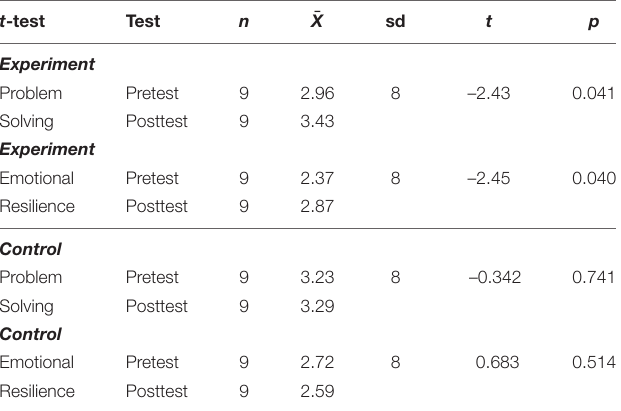
TABLE 4 | Problem-solving and emotional resilience